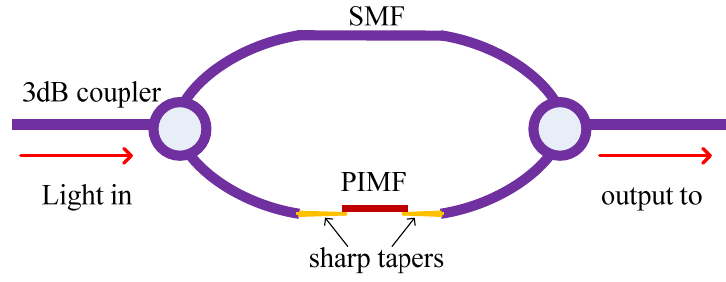
Figure 19. The MZI sensor based on PIMF and SMF [87].